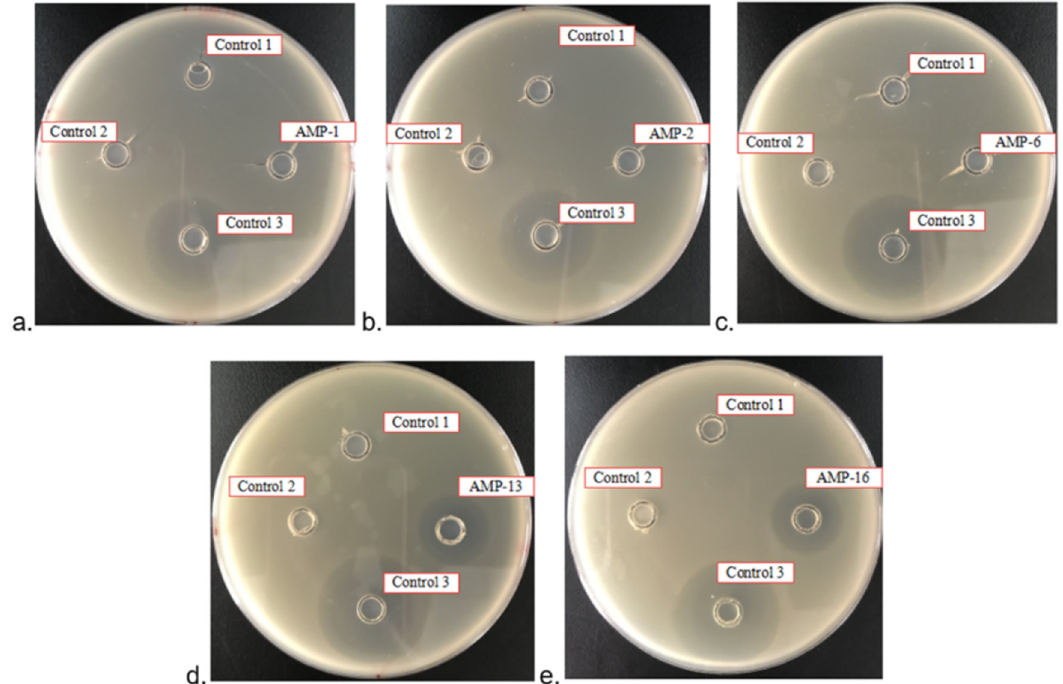
Figure 7. Inhibition zone tests of AMP 1, 2, 6, 13 and 16. Control 1, HRV 3C Cleavage Buffer; Control 2, HRV 3C Cleavage Buffer with 1 M NaCl; Control 3, Positive control, ampicillin antibiotic at a concentration of 200 mg/L. ( a ) Inhibition zone tests of AMP1; ( b ) Inhibition zone tests of AMP2; ( c ) Inhibition zone tests of AMP6; ( d ) Inhibition zone tests of AMP13; ( e ) Inhibition zone tests of AMP16. Every oxford cup contains 100 μ L liquid.